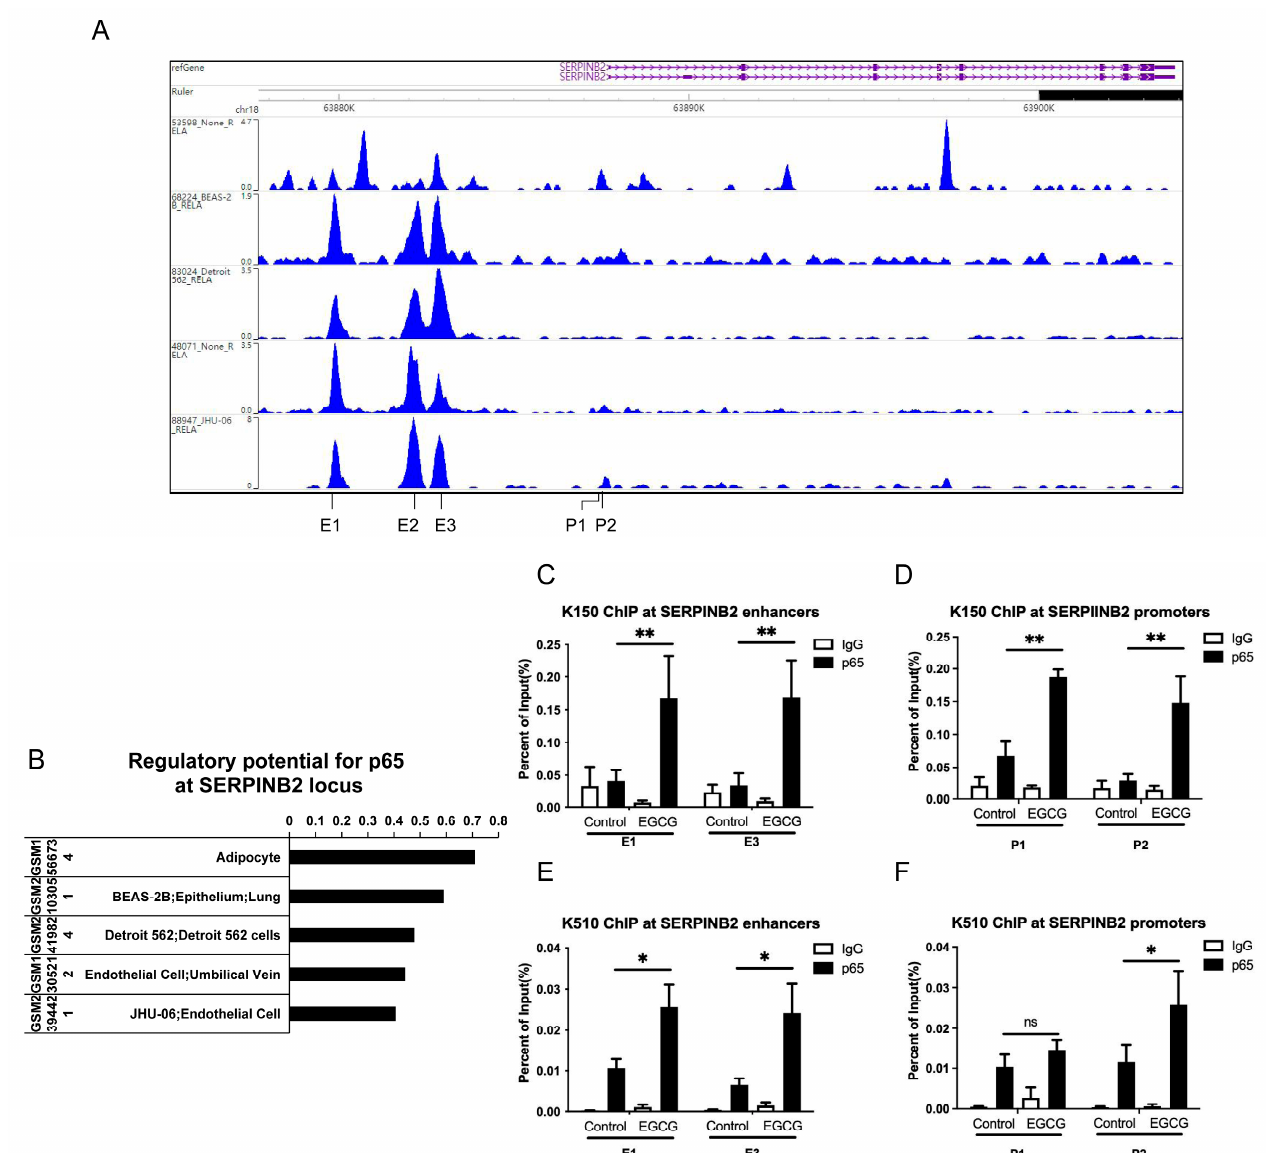
Figure 5. Prediction and verification of p65 binding sites on the promoter and enhancers of SERPINB2. ( A ) Cistrome screenshot showing p65 binding peaks near the SERPINB2 locus in adipocyte, lung epithelial cells, Detroit cells, and endothelial cells. ( B ) Regulatory potential for p65 at SERPINB2 locus within 5 cell lines. ( C , D ) ChIP-qPCR in KYSE150 cells before and after EGCG treatment showing p65 enrichment over the enhancer E1 and E3 ( C ) and the promoter ( D ) regions ( E , F ). ChIP-qPCR in KYSE510 cells before and after EGCG treatment showing p65 enrichment over the enhancer E1 and E3 ( E ) and the promoter ( F ) regions. Data are shown as mean ± SD. n = 3, *: p < 0.05; **: p < 0.01; ns: not significant.